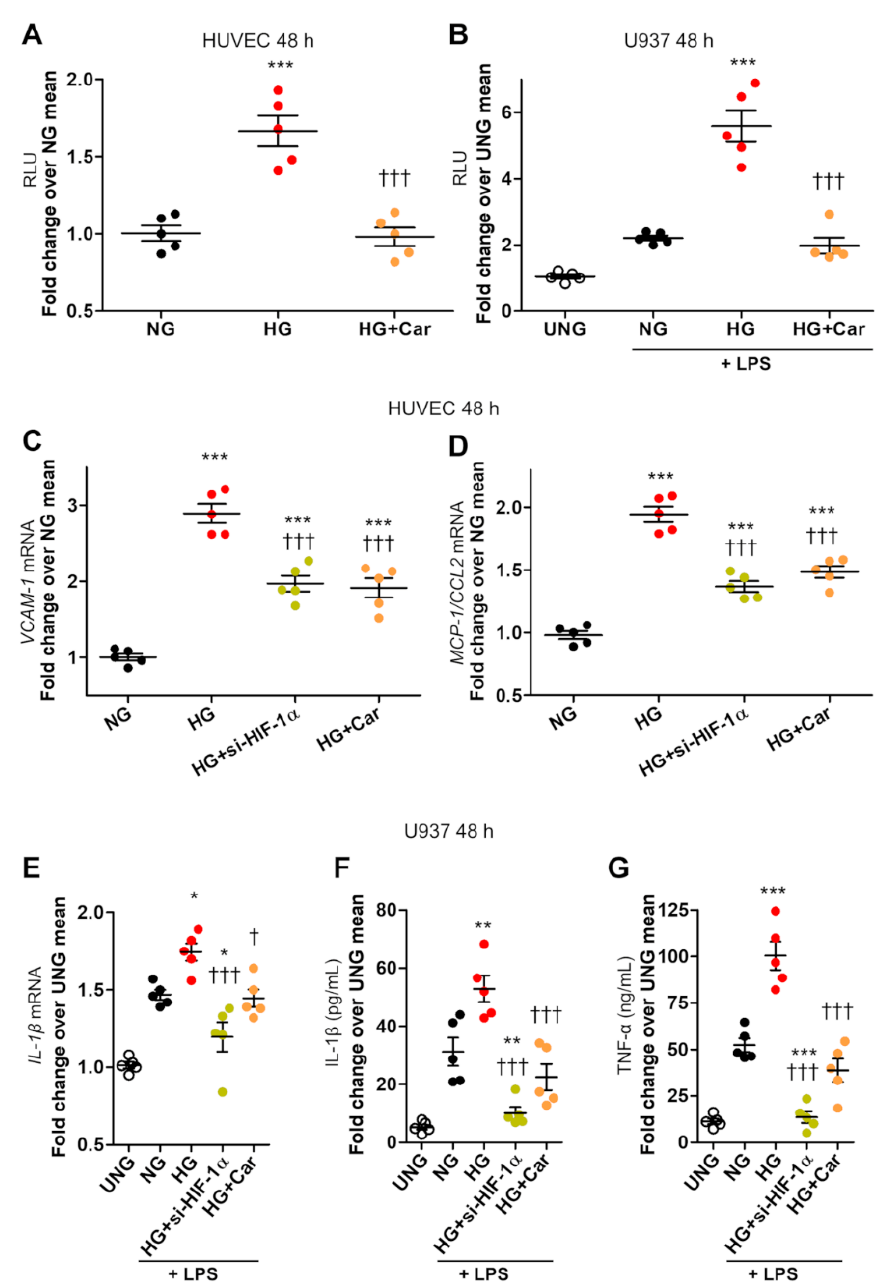
Figure 2. HG-induced HIF-1 α activity is associated with proinflammatory activation in endothelial cells and LPS-stimulated macrophages. HIF-1 activity, as assessed by dual-luciferase gene reporter assay, in HUVEC ( A ), and in U937 macrophages stimulated (or not, UNG = untreated normal glu- cose) with LPS (10 ng/mL) ( B ), after 48 h incubation with HG (20 mM) vs. NG (5.5 mM), with or without Car (20 mM); n = 5 wells in duplicate per condition. VCAM-1 ( C ) and MCP-1 / CCL2 ( D ) mRNA levels in HUVEC, and IL-1 β mRNA levels in U937 macrophages stimulated (or not, UNG) with LPS ( E ), exposed to HG vs. NG for 48 h, silenced for HIF-1 α (si- HIF-1 α ), or treated with Car; n = 5 wells in duplicate per condition. IL-1 β ( F ) and TNF- α ( G ) protein levels in the culture medium of U937 cells stimulated (or not, UNG) with LPS after 48 h incubation with HG vs. NG, silenced for HIF-1 α , or treated with Car; n = 5 wells in duplicate per condition. Each dot represents the mean of two individual technical replicate and bars represent mean ± SEM. Post hoc multiple comparison: *** p < 0.001, ** p < 0.01 or * p < 0.05 vs. NG; ††† p < 0.001 or † p < 0.05 vs. HG.